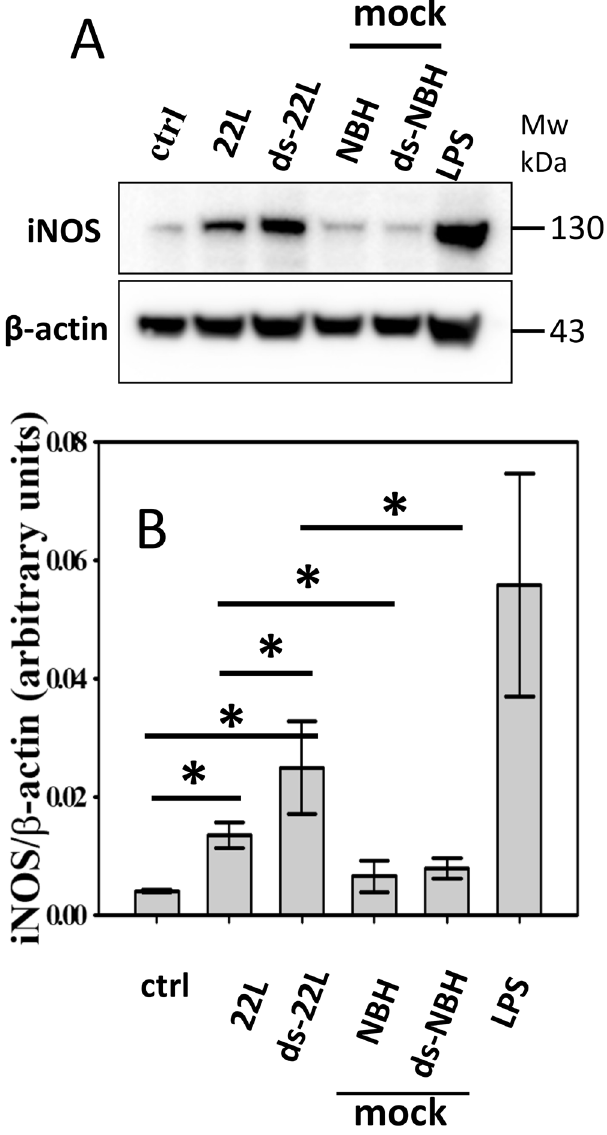
Figure 3. Analysis of iNOS expressions in BV2 microglia cells. ( A ) Western blot analysis of expression levels of iNOS in BV2 cells exposed to purified 22L or ds-22L PrP Sc for 18 hours. As negative controls, cells were treated with mock-purified NBH or ds-NBH, or cultured in the absence of treatment (ctrl). As a positive control, cells were treated with LPS (100 ng/ml). The final concentrations of 22L or ds-22L PrP Sc in the cell culture media were equivalent to the amounts of PrP Sc in 0.75% 22L scrapie brain homogenate. The experiment was performed three times. Western blots probed with anti- β actin antibody served as protein loading control. Full-length Western blots are shown in Supplementary Fig. S4. ( B ) Densitometry analysis of iNOS expression in BV2 cells exposed to purified 22L or ds-22L PrP Sc . The data were normalized relative to the intensity of the β actin. The data are presented as the mean ± SD (n = 3 independent experiments). Statistical significance (P) were calculated by Student’s t-test and indicated as * for P <